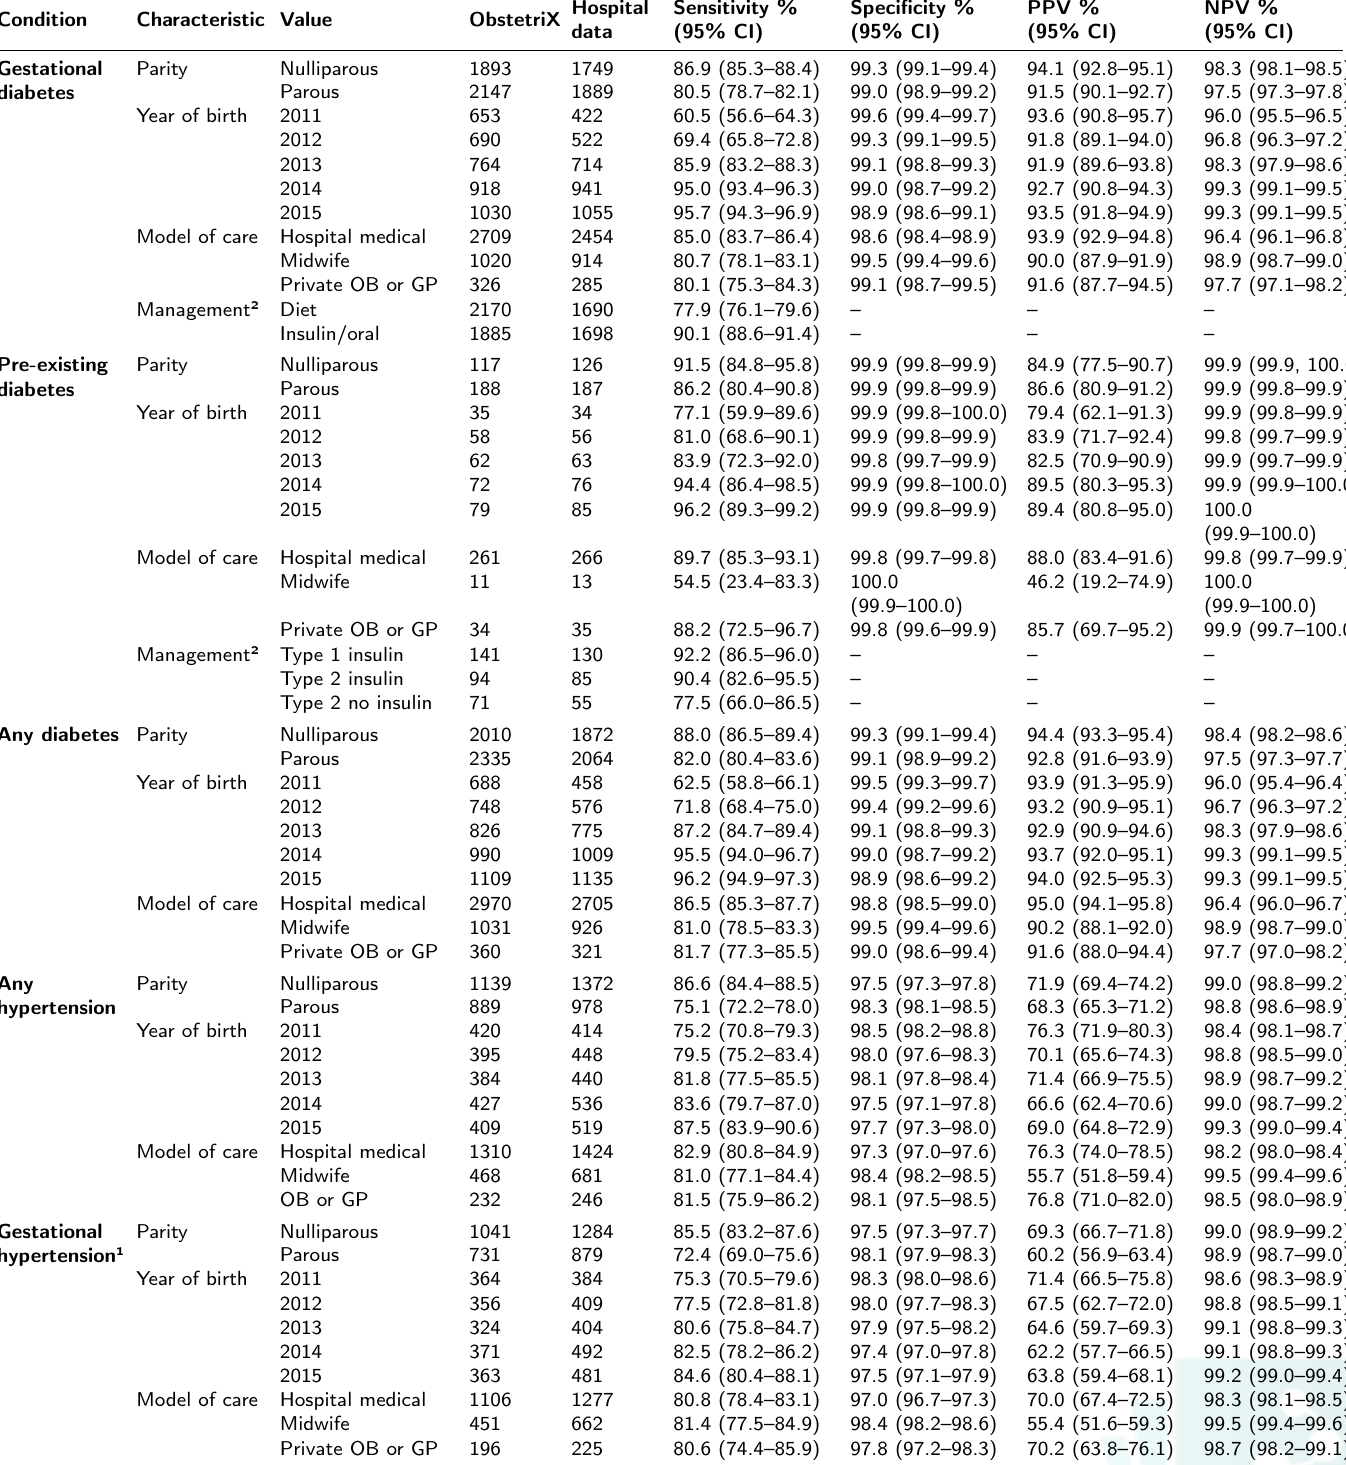
Table 2: Reliability of reporting of gestational diabetes and hypertension in coded hospital data from two tertiary hospitals in New South Wales, 2011–2015, by characteristics of